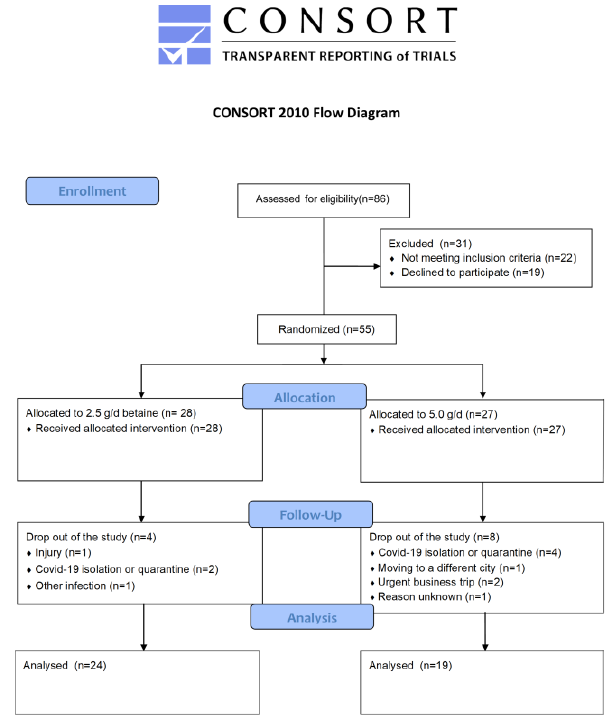
Figure 1. Consort flow diagram.